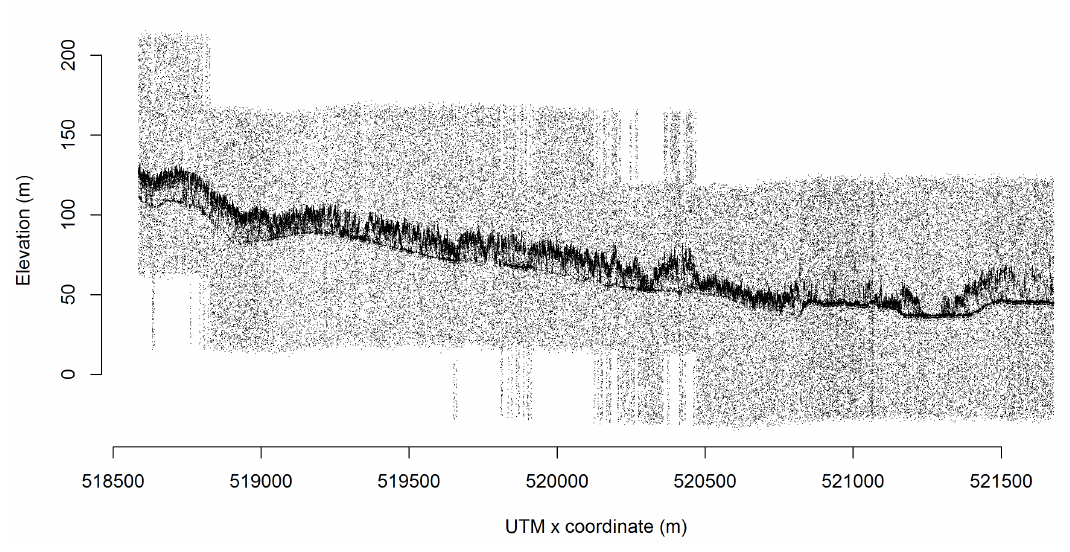
Figure 2. The profile of the photon counting LiDAR data from SIMPL within the Howland Research Forest. The horizontal x-axis stands for the UTM x coordinate; the vertical y-axis stands for the ellipsoidal